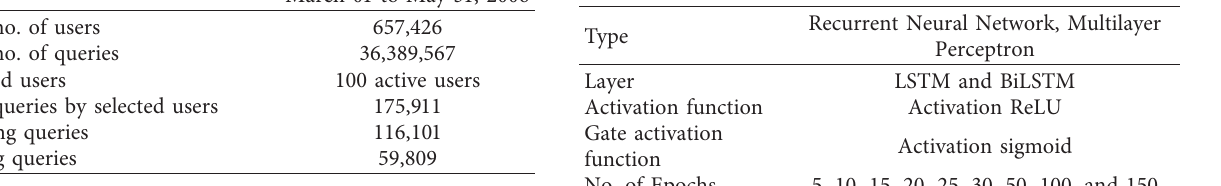
Figure 2: Operation of the NN-QuPiD Attack model. Table 1: Dataset properties. Table 2: Parameters Recurrent Neural Network (RNN) for NN- QuPiD